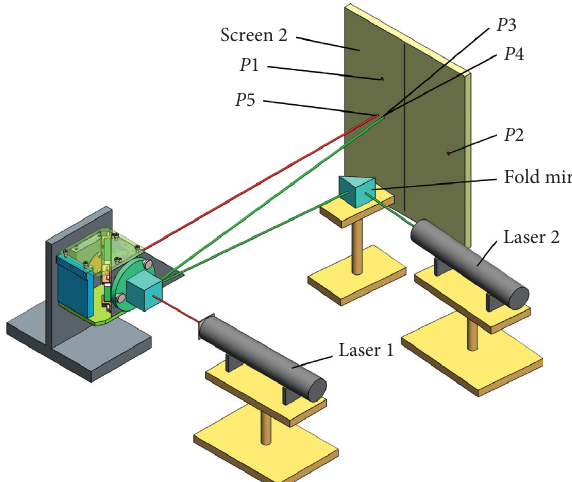
Figure 13: Adjustment of the TSM (Step